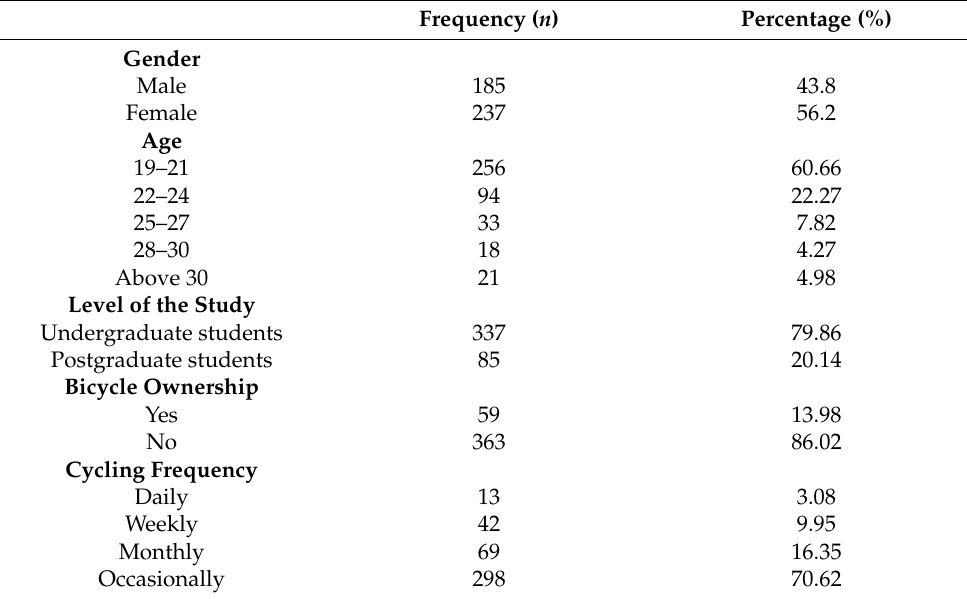
Table 2. Socio-demographic profile of the respondent ( n =